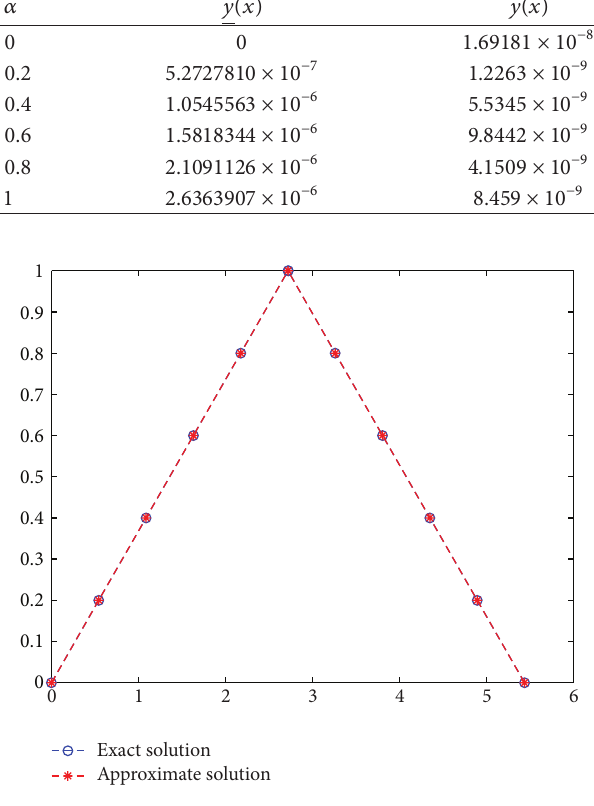
Figure 2: Graph at 𝑥 = 1